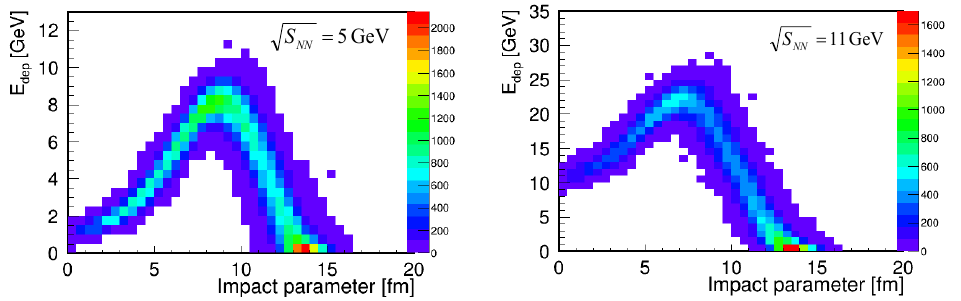
Figure 3. The dependence of energy deposition in FHCal on the centrality for the Au + Au collisions √ √ s NN = 5 GeV (left) and s NN = 11 GeV with energy